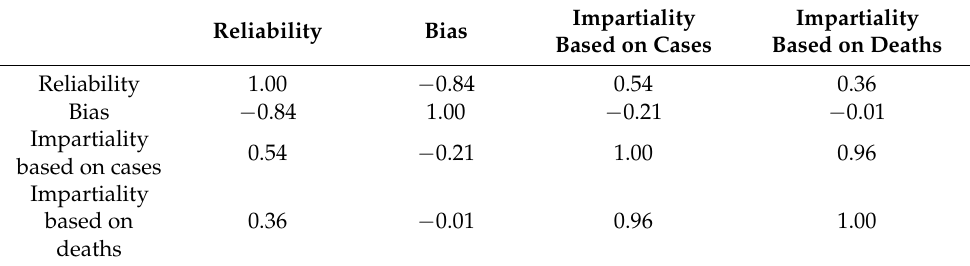
Table 4. The Pearson correlation between the sentiment values and the number of